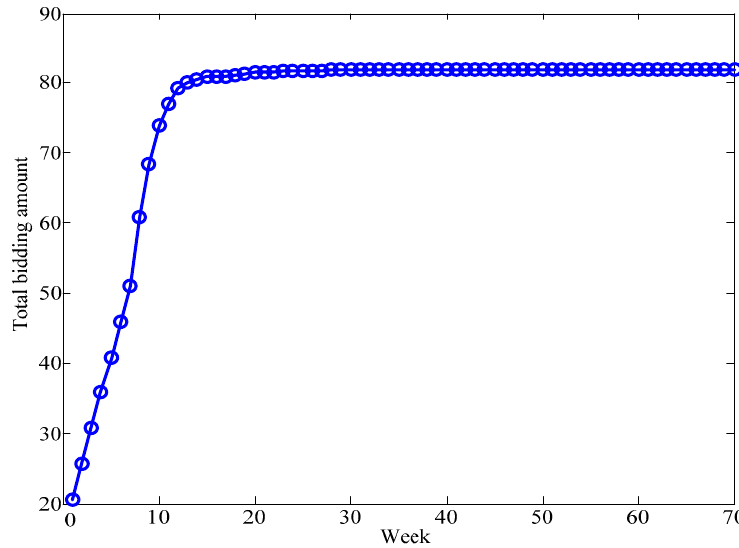
Figure 4. Convergence process of total bidding amount in group N. 417